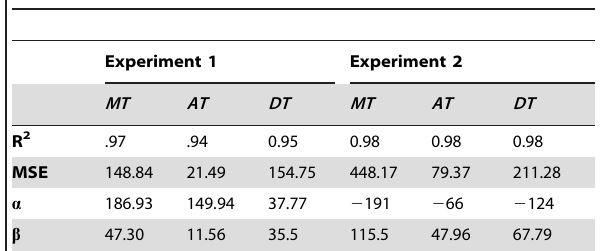
Table 2. Linear regressions’ estimates for mean data across